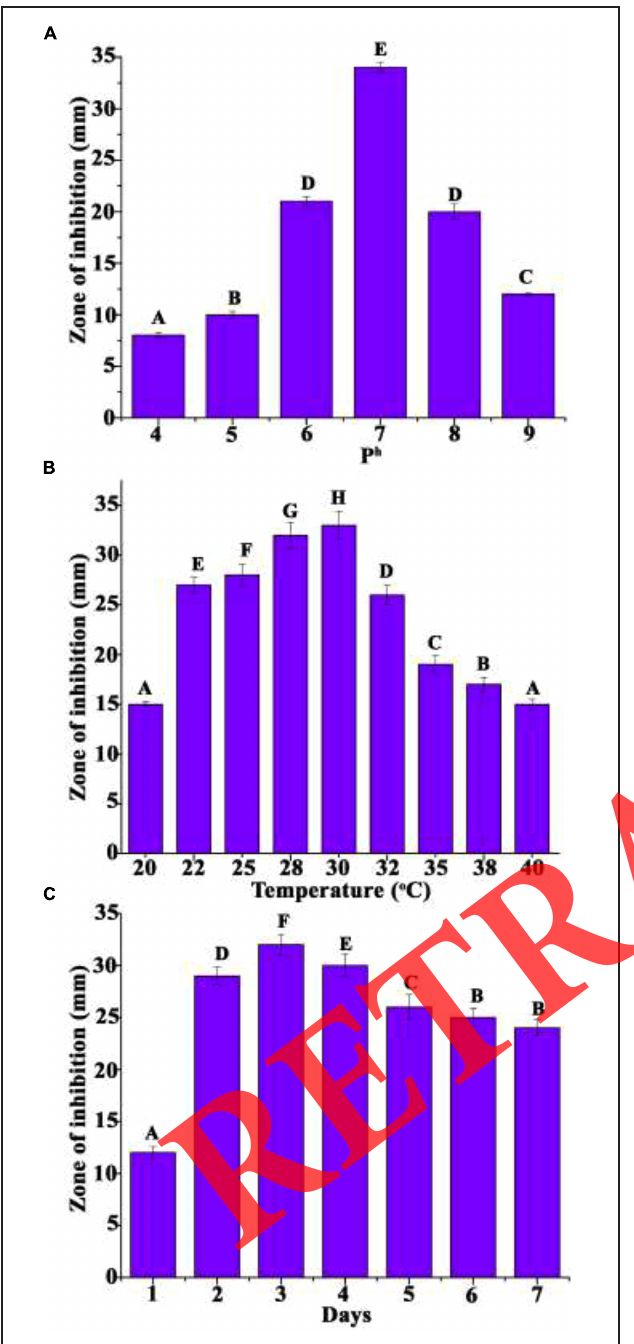
FIGURE 6 | Effect of cultural parameters on production of antimicrobial agent. (A) p H , (B) temperature and (C) days. Different letters in the superscript were significantly different according to Duncan’s multiple range test ( p < 0.05).